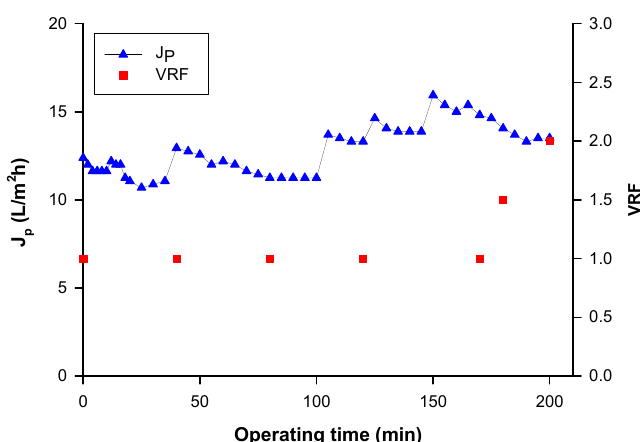
Figure 6. Treatment of clarified Goji berries extract with GH membrane. Time course of the permeate flux and VRF (Operating conditions: diafiltration/batch concentration; TMP, 16 bar, T, 30 ± 1 °C). Table 3. Chemical composition of the clarified Goji berries extract before and after the diafiltration/concentration process with the GH membrane.